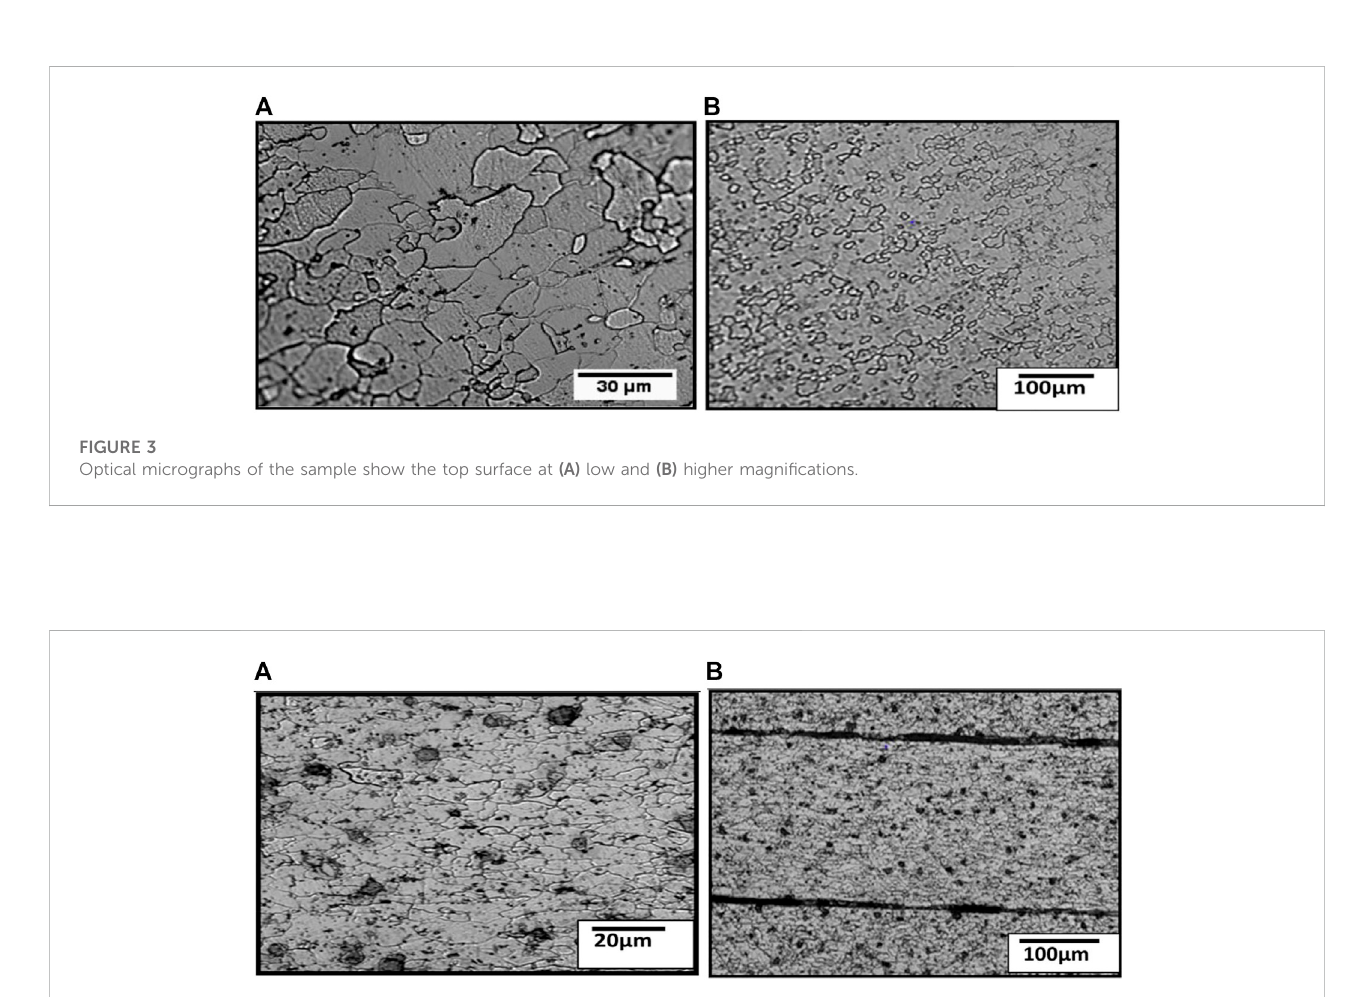
FIGURE 4 Optical micrographs of the sample show the cross-section of substrate steel at (A) low and (B) higher magni fi cations.